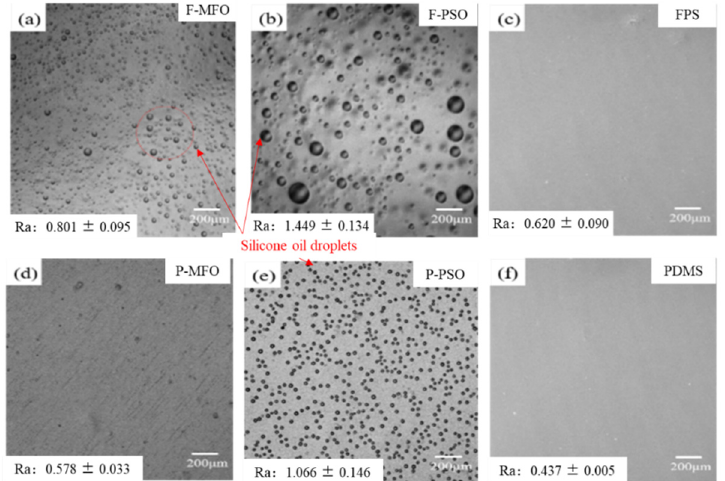
Figure 4. CLSM surface morphology and roughness of studied coatings: ( a ) F-MFO; ( b ) F-PSO; ( c ) FPS; ( d ) P-MFO; ( e ) P-PSO; ( f ) PDMS.